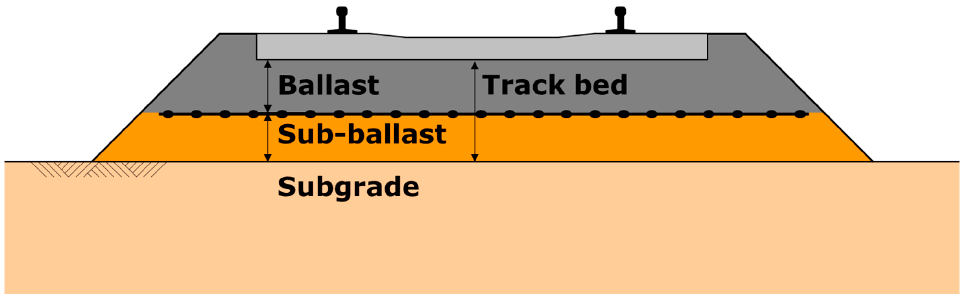
Figure 24. Location of the geogrid for ballast stabilisation